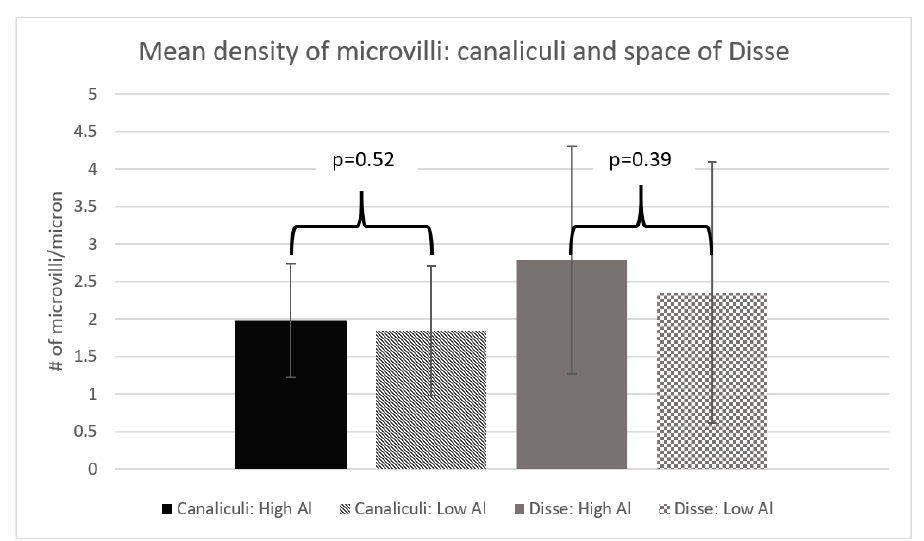
Figure 4. Mean area and perimeter of canalicular space.